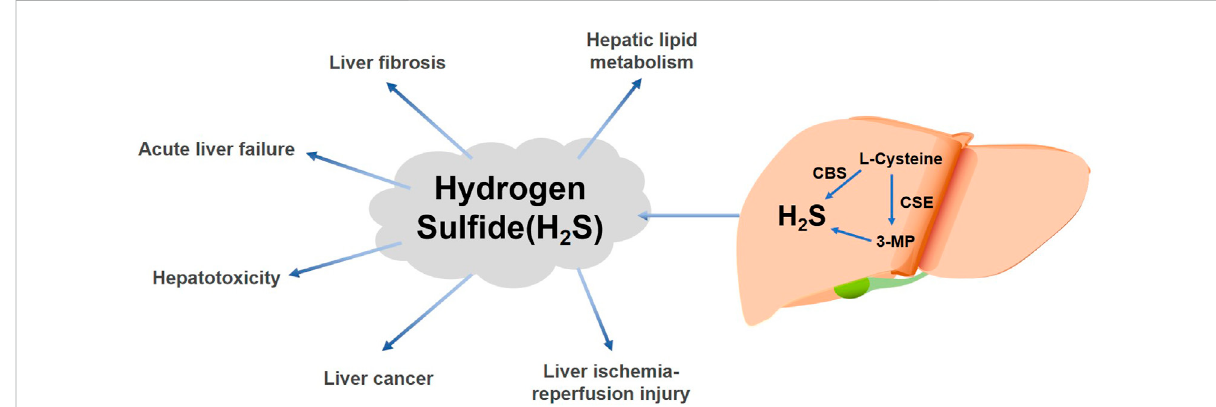
FIGURE 1 Effects of liver-derived H 2 S on various liver diseases. H 2 S is produced in the liver by the enzymatic reactions of cysteine gamma-catabolase (CSE)(Jiaetal.,2022),cystathionine β -synthase(CBS)(Royetal.,2012;Zuhraetal.,2020a),and3-mercaptopyruvate(3-MP) via L-cysteine(Royetal., 2012; Abdollahi Govar et al., 2020; Dilek et al., 2020). H 2 S can have different effects in various liver diseases.